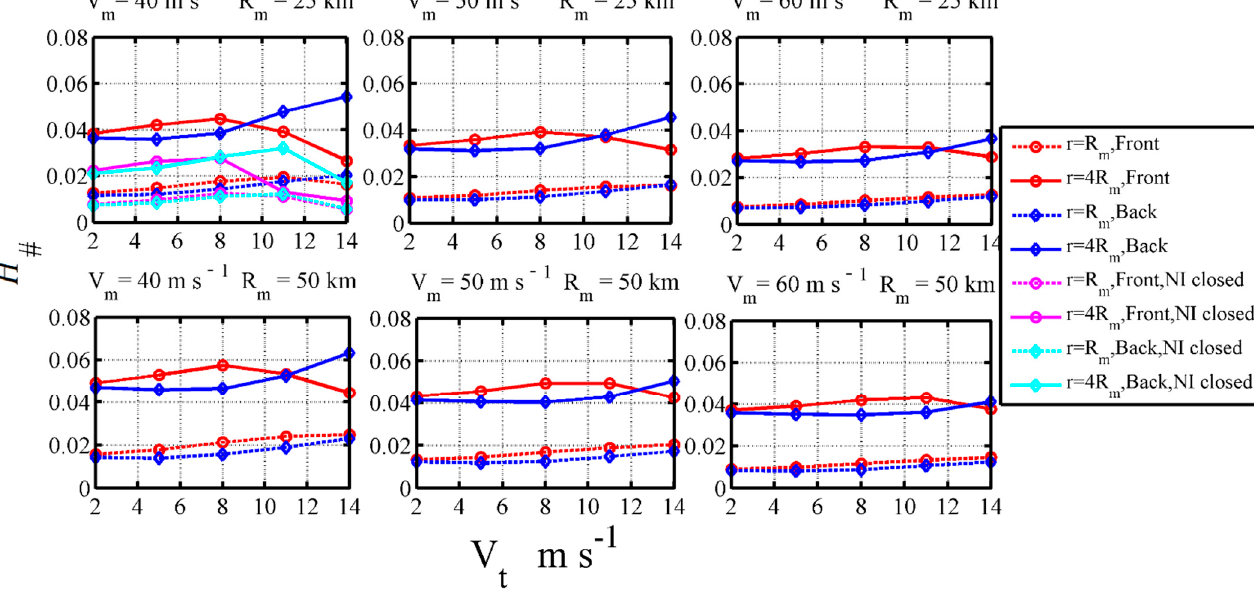
Figure 5. Modelling results of T # . The lines correspond to different radial distances, such as r = R m , and sectors in terms of front or back and model setting with nonlinear interaction (NI) closed or not.